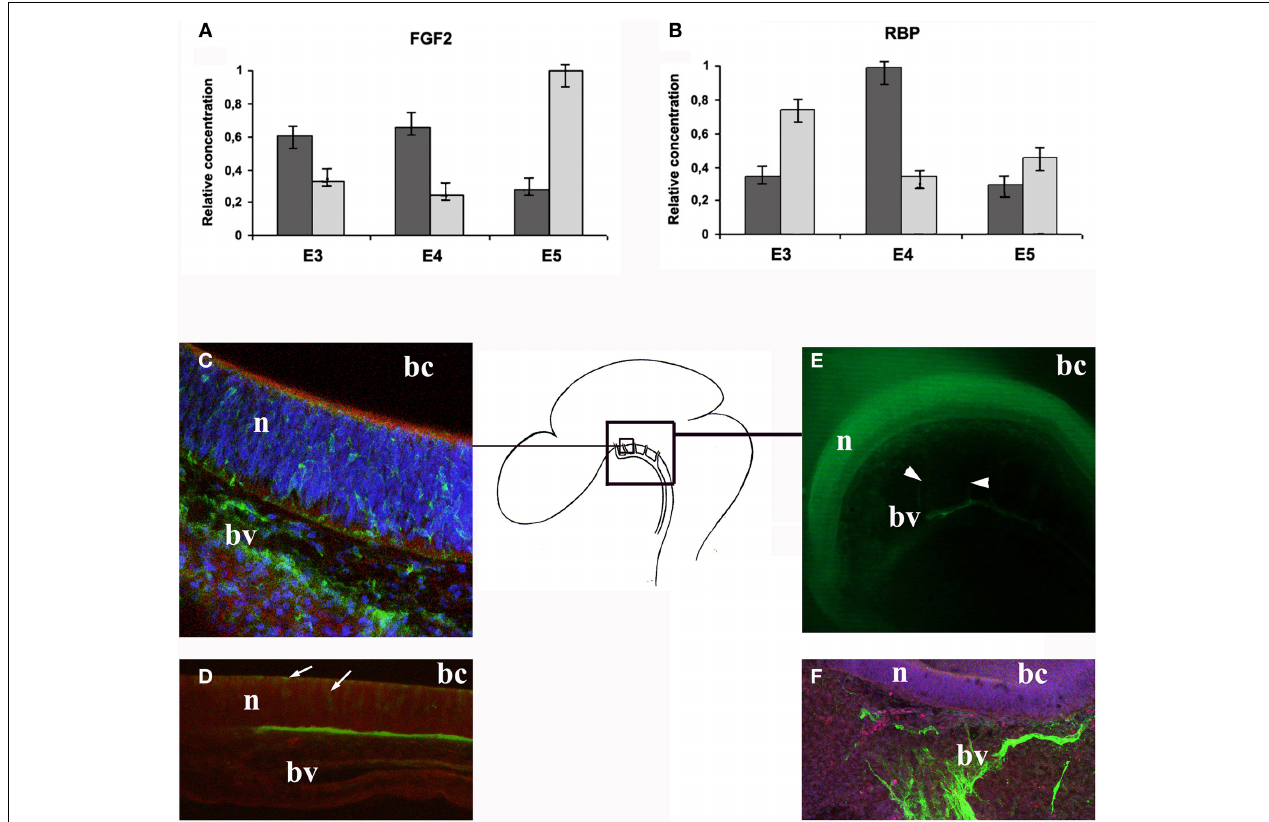
FIGURE 4 | Transport of molecules across the blood–eCSF barrier in chick embryos. (A-B) Relative concentrations of some endogenous proteins in the embryonic serum (light gray), and in the eCSF (dark gray), at E3, E4, and E5 developmental stages (Parvas et al., 2008a). (C) Vibratome section showing transport of BDA3000 injected into the cephalic cavities at the ventral mesencephalon, lateral to the floor plate, at E4 (Parvas et al., 2008a). Note the presence of fluorescent dextran in both blood vessels (bv) and across the neuroectoderm (n). (D) Vibratome section showing transport of BSA microinjected into the